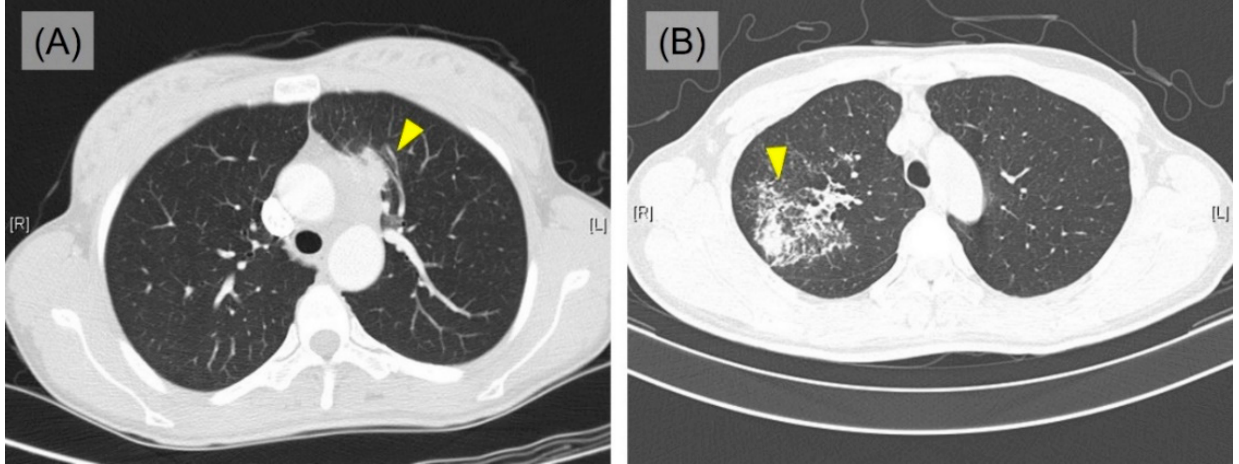
Figure 1. Imaging findings of PPHL. ( A ) Single mass (yellow arrowhead; case 4). ( B ) Consolidation (yellow arrowhead; case 9).